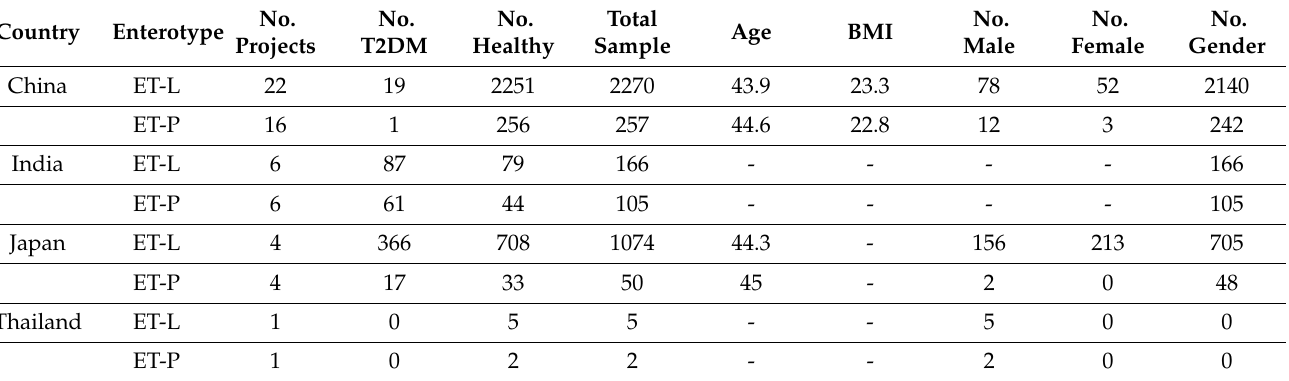
Table 1. Characteristics of human fecal samples collected from the National Center for Biotechnology Information (NCBI)